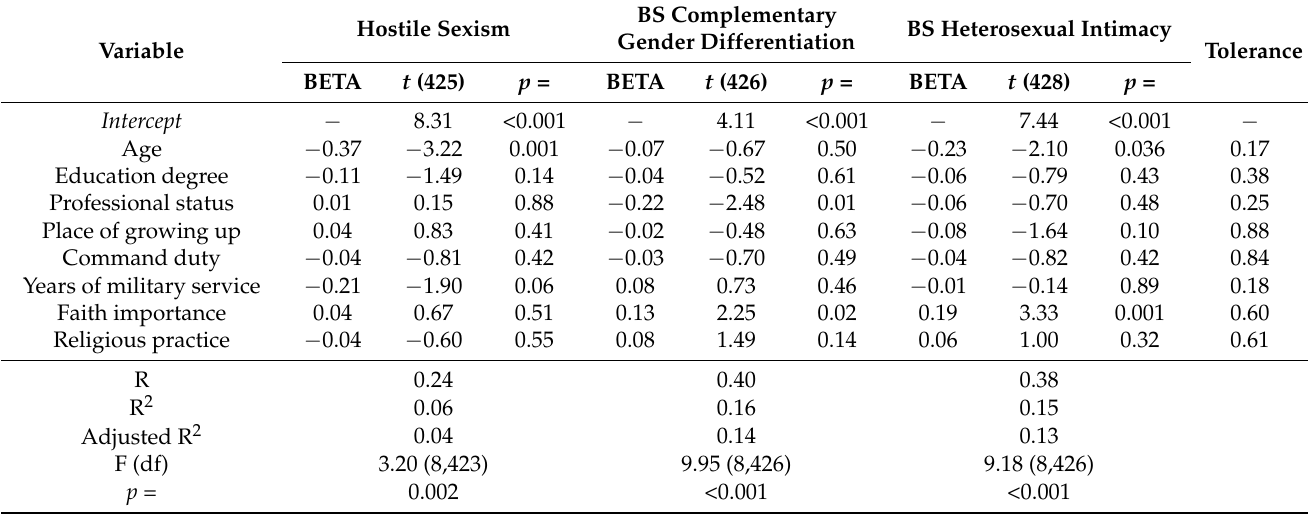
Table 6. Determinants of the sexism measures among